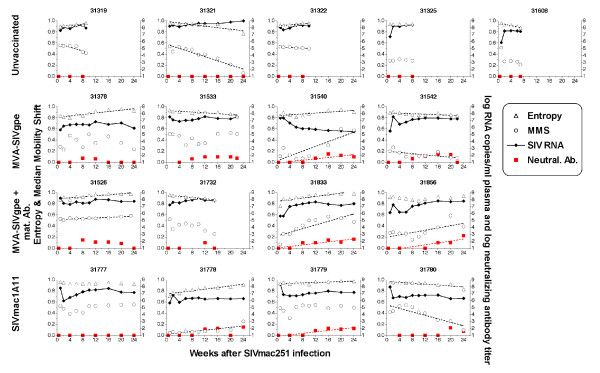
Evolution of viral diversity and SIV neutralizing antibody response. HMA data for each animal (Fig. 4) were further analyzed by calculating the entropy and the median mobility shift (MMS). Viral RNA levels were measured by bDNA. SIV neutralizing antibodies were determined as described in the Materials and Methods; neutralizing antibody titers below cut-off value (i.e., < 30) were given a value of 10 for presentation on these graphs. Dashed lines indicate a regression line for entropy, MMS or neutralizing antibody titer that is significantly different (P < 0.05) from zero (i.e. significantly increasing or decreasing values from 1 week to 24 weeks pc, with r2 values ≥ 0.45).